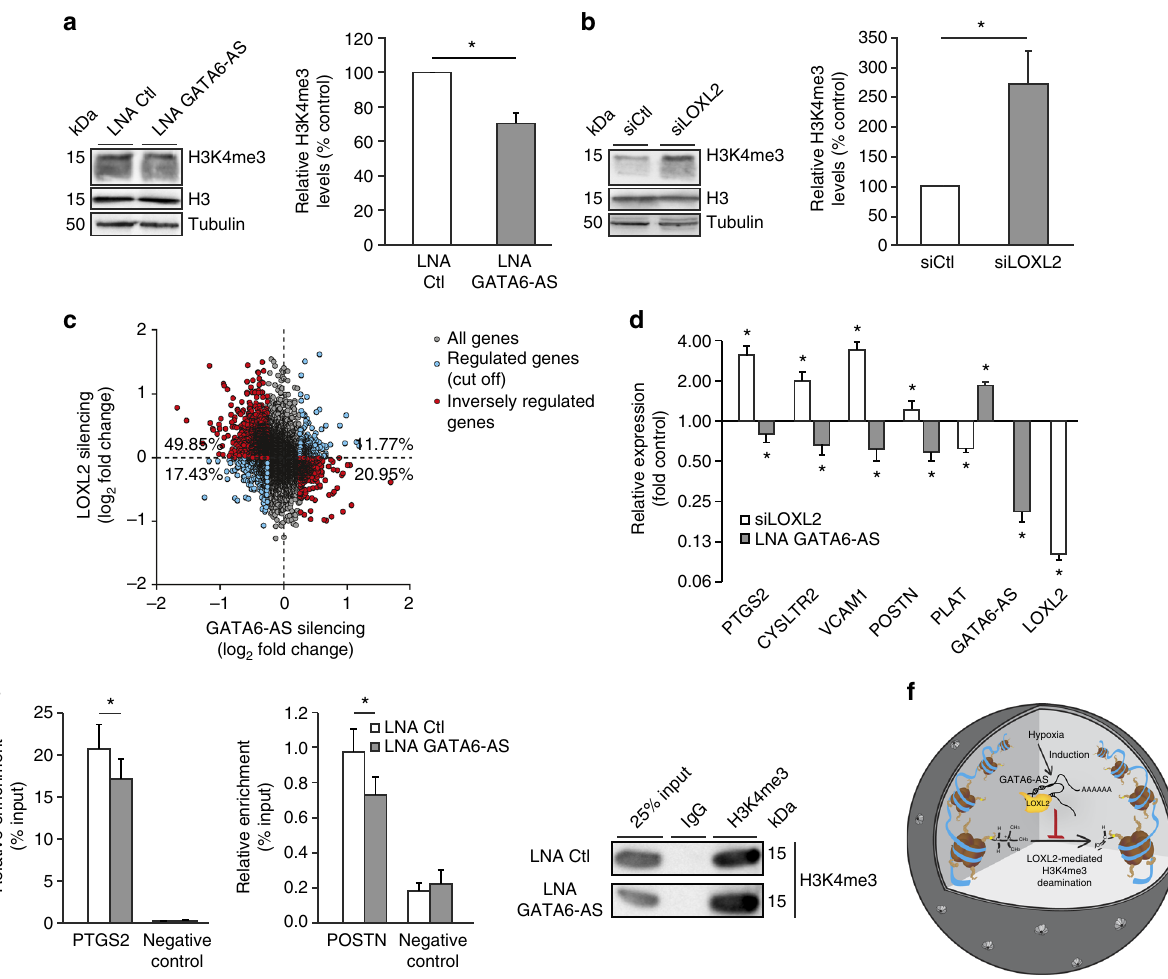
Fig. 6 GATA6-AS acts as negative regulator of nuclear LOXL2 function in endothelial gene expression. a , b Left: HUVECs were transfected with GapmeRs or siRNAs targeting GATA6-AS or LOXL2, respectively and H3K4me3, H3 as well as tubulin levels were assayed by western blotting (representative images are shown). Right: For quanti fi cation, H3K4me3 levels were normalized to tubulin ( n = 3 – 6; SEM; * t test p < 0.05). c Upon silencing of GATA6-AS, changes in global gene expression levels were determined by exon arrays (all genes; gray). Regulated genes ( ≥ 1.2 fold upregulated or downregulated) were analyzed in corresponding LOXL2-silenced samples (cut off; blue) and when found inversely regulated, highlighted in red. Percentages refer to the total of all cut off genes. Six data points are outside the axis limits ( n = 2 – 4). d HUVECs were transfected with siRNAs or GapmeRs targeting LOXL2 or GATA6-AS, respectively and expression of LOXL2 and GATA6-AS, as well as of the indicated angiogenesis-related genes was determined by RT-qPCR, normalized to RPLP0 mRNA ( n = 7 – 8; SEM; * t test p < 0.05). e HUVECs were transfected with GapmeRs targeting GATA6-AS or with control GapmeRs and used for H3K4me3 chromatin immunoprecipitations. Left: Co-precipitated DNA was assayed for PTGS2 and POSTN enrichment by qPCR. A genomic region lacking H3K4me3 signals was used as negative control ( n = 4 – 10; SEM; * t test p < 0.05). Right: Speci fi city of the immunoprecipitation was controlled by isotype controls and H3K4me3 western blotting (representative images are shown). f Schematic model of GATA6-AS-regulated LOXL2 function. In the nucleus, LOXL2 catalyzes the oxidative deamination of activating H3K4me3 chromatin marks, a process which is negatively regulated by the hypoxia-induced nuclear lncRNA